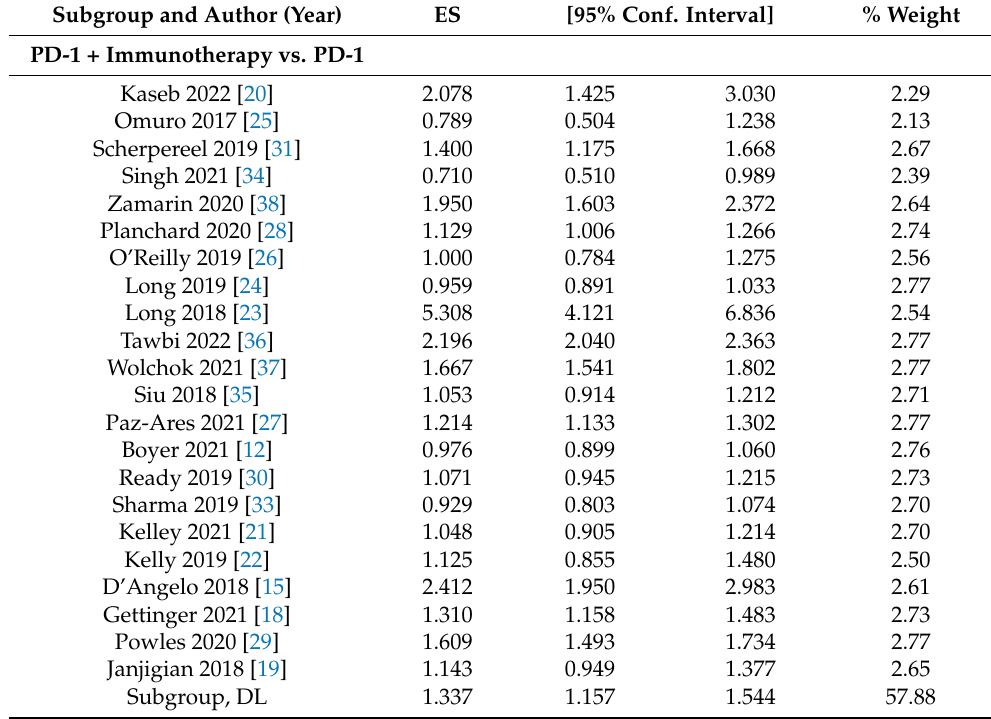
Table 3. Median survival ratio of PFS based on therapeutic